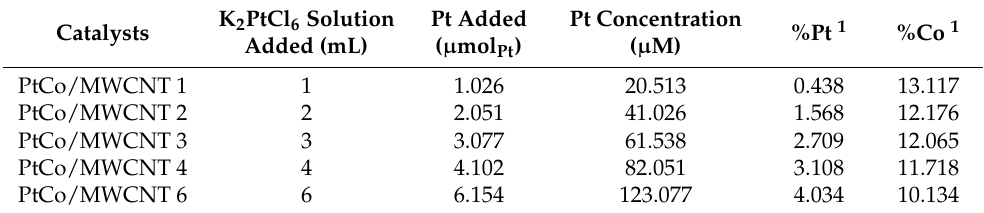
Table 2. Pt concentration solution for each catalyst and metal percentages (Pt and Co) of the synthesized catalysts.